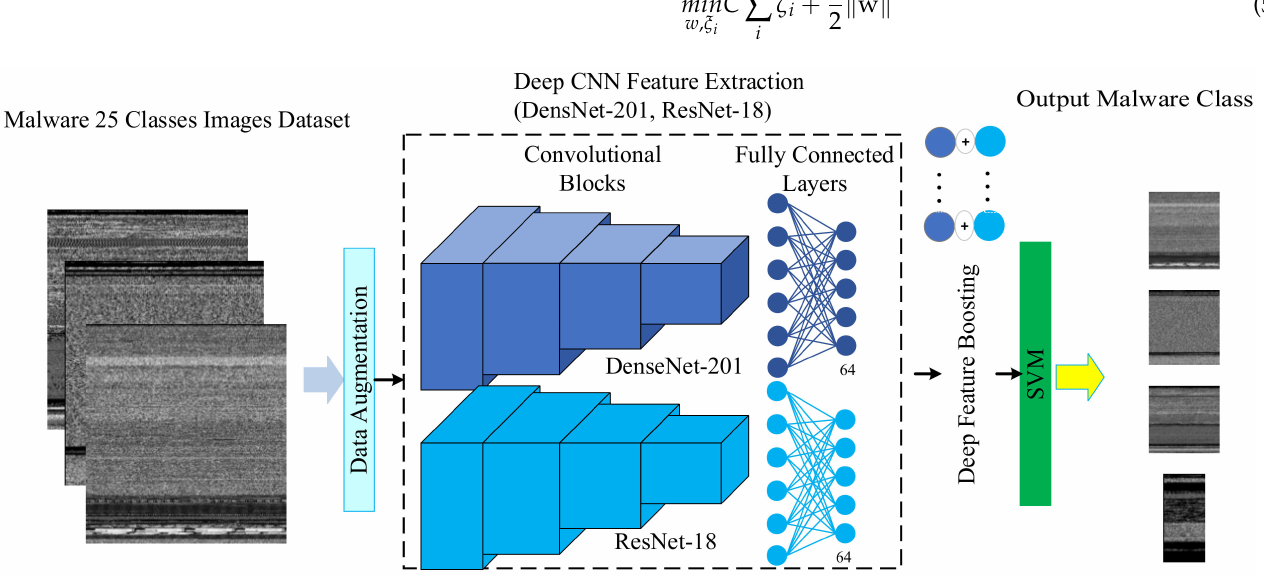
Figure 4. Flow diagram of the proposed DBFS-MC malware classification approach.